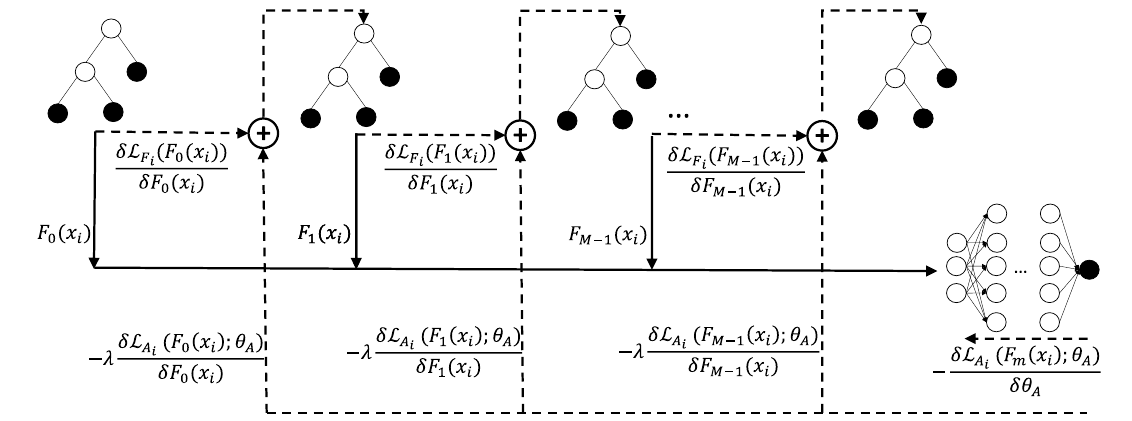
Fig. 1 The architecture of the fair adversarial gradient tree boosting (FAGTB). Four steps are depicted, each one corresponding to a tree h that is added to the global classifier F . The neural network on the right is the adversary that tries to predict the sensitive attributes from